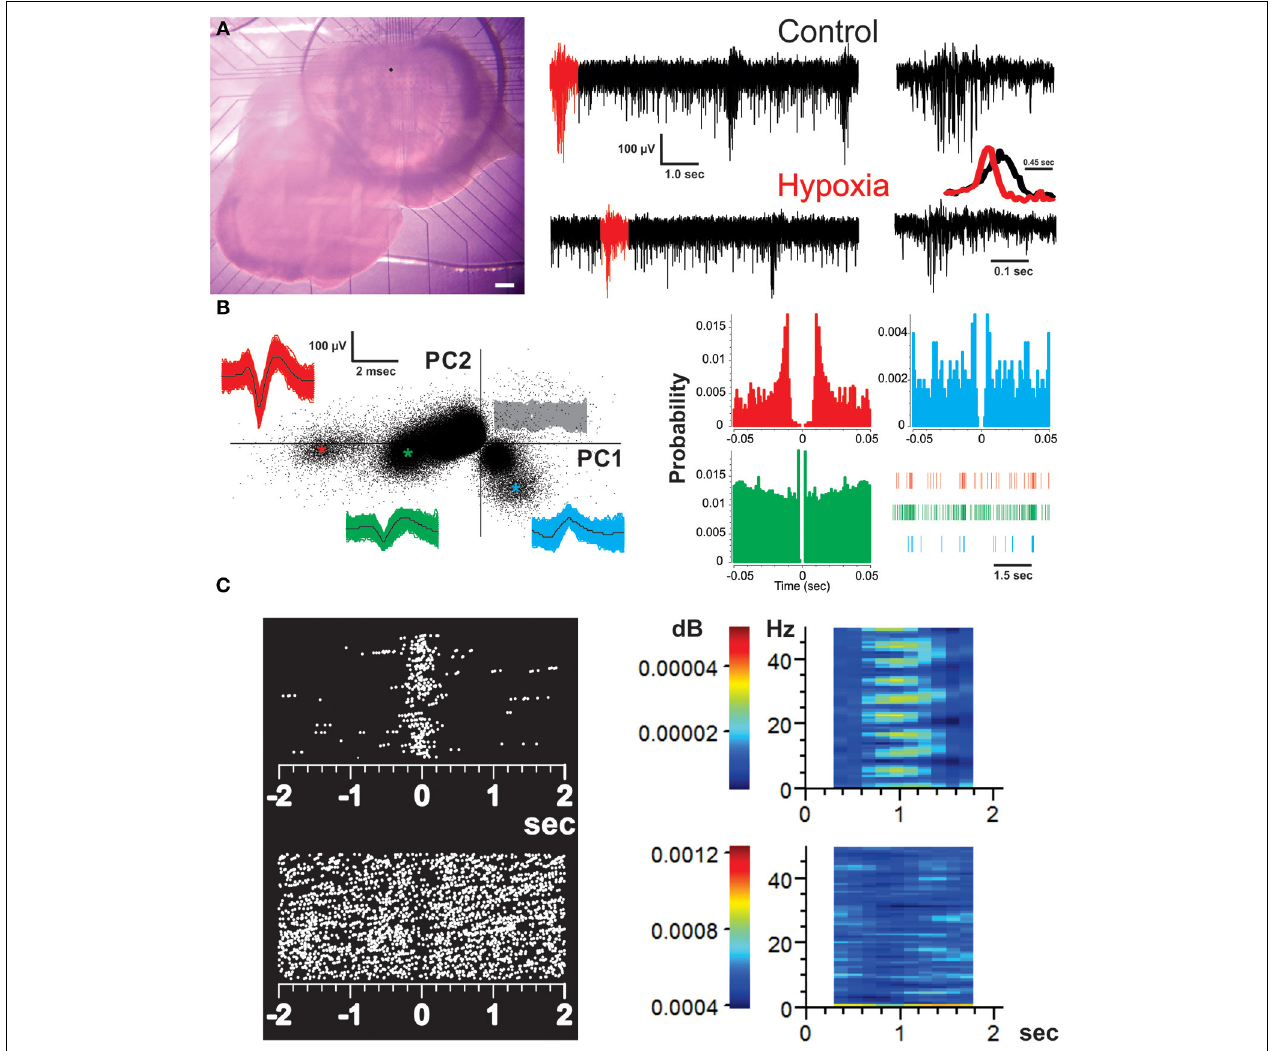
FIGURE 1 | Recording of the respiratory network with multielectrode arrays (MEAs) and identification of respiratory units. (A) Micrograph of a brainstem slice preparation on top of a MEA that covers the area of the ventral respiratory group (including the preBötC). Scale bar represents 200 µ m. The dot on the slice represents the location of the MEA electrode from which the recordings represented on the right were taken. The recordings from the chosen electrode show spontaneous activity of the preBötC in normoxic (control) and hypoxic conditions. The bursts in red were expanded on the right to better appreciate the difference in burst pattern between fictive-eupnea (control) and fictive-gasping (hypoxia). The inset shows the averaged peak-to-peak amplitude for 30 bursts in normoxia (black) and hypoxia (red). Note the reduction in burst duration and rise-time in those bursts generated in hypoxia. (B) Spike sorting analysis of the chosen